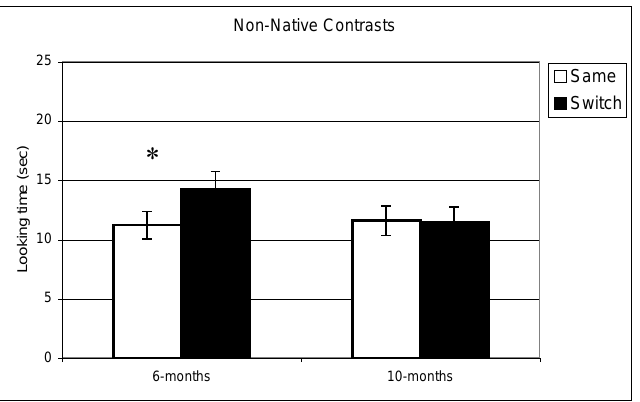
Figure 2. Looking time during same and switch trials for non-native contrasts at 6- and 10-months (* p <